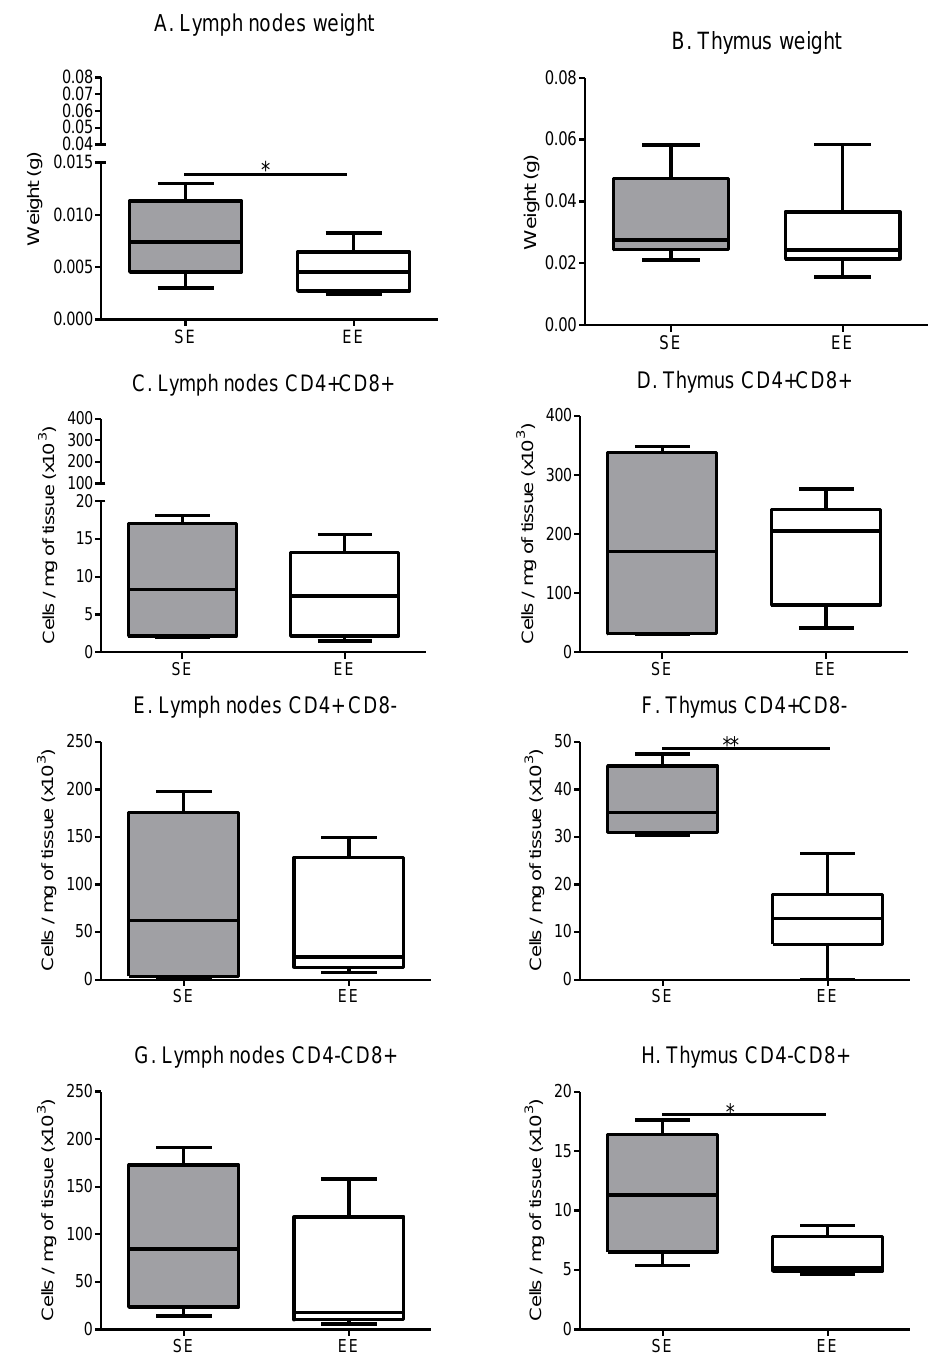
Figure 9. Immune lymphocytes maturation in secondary immune organs. ( A ) Lymph node weight depending on the environment, results are grams. ( n = 10 mice/group) ( B ) Thymus weight depending on the environment, results are grams. ( n = 10 mice/group) ( C ) Lymph node CD4+ CD8+ maturation, results are in cells per mg of tissue. ( D ) Thymus CD4+ CD8+ maturation, results are in cells per mg of tissue. ( E ) Lymph node CD4+ CD8 − maturation, results are in cells per mg of tissue. ( F ) Thymus CD4+ CD8 − maturation, results are in cells per mg of tissue. ( G ) Lymph node CD4 − CD8+ maturation, results are in cells per mg of tissue ( H ) Thymus CD4 − CD8+ maturation, results are in cells per mg of tissue. Phenotyping is performed on 5 mice tissue/group. Data are expressed as mean ± SEM. Data were analysed by Mann–Whitney t -test. Representative data are shown: * p < 0.05, ** p < 0.01, SE vs. EE.